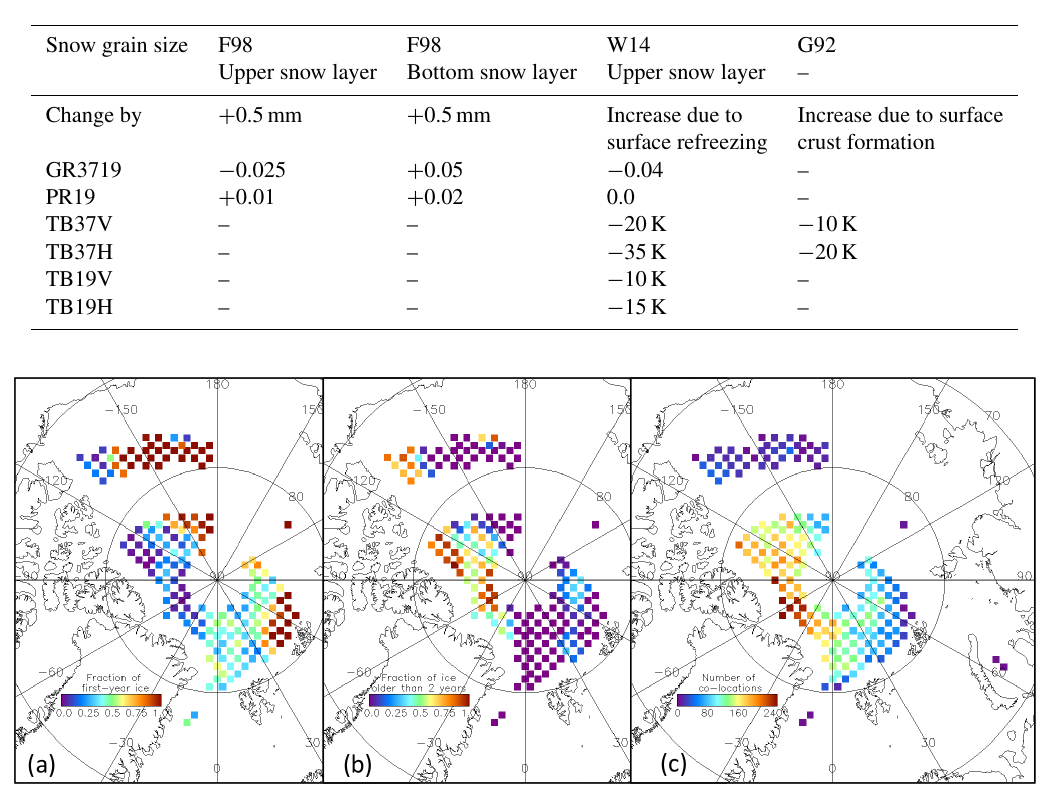
Table 3. Typical values of changes in brightness temperature due to changes in snow grain size. For abbreviations TB, PR, GR, V, and H see Table 1. Abbreviations F98, W14, and G92 refer to Fuhrhop et al. (1998), Willmes et al. (2014), and Garrity (1992), respectively.